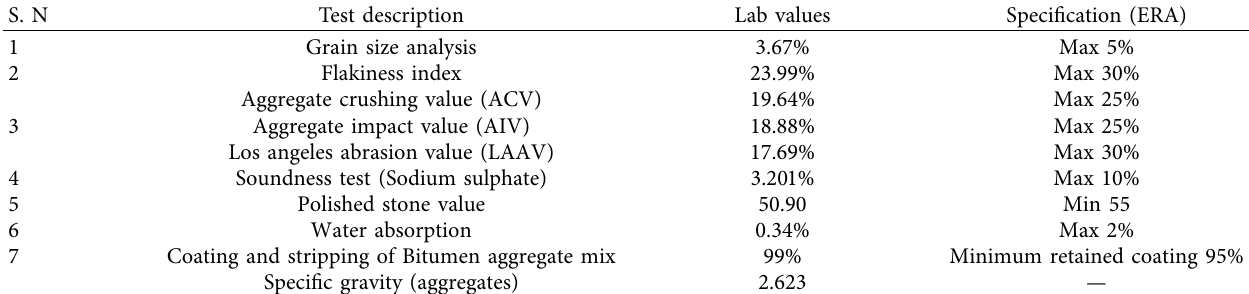
Table 7: Test results of gradation aggregate